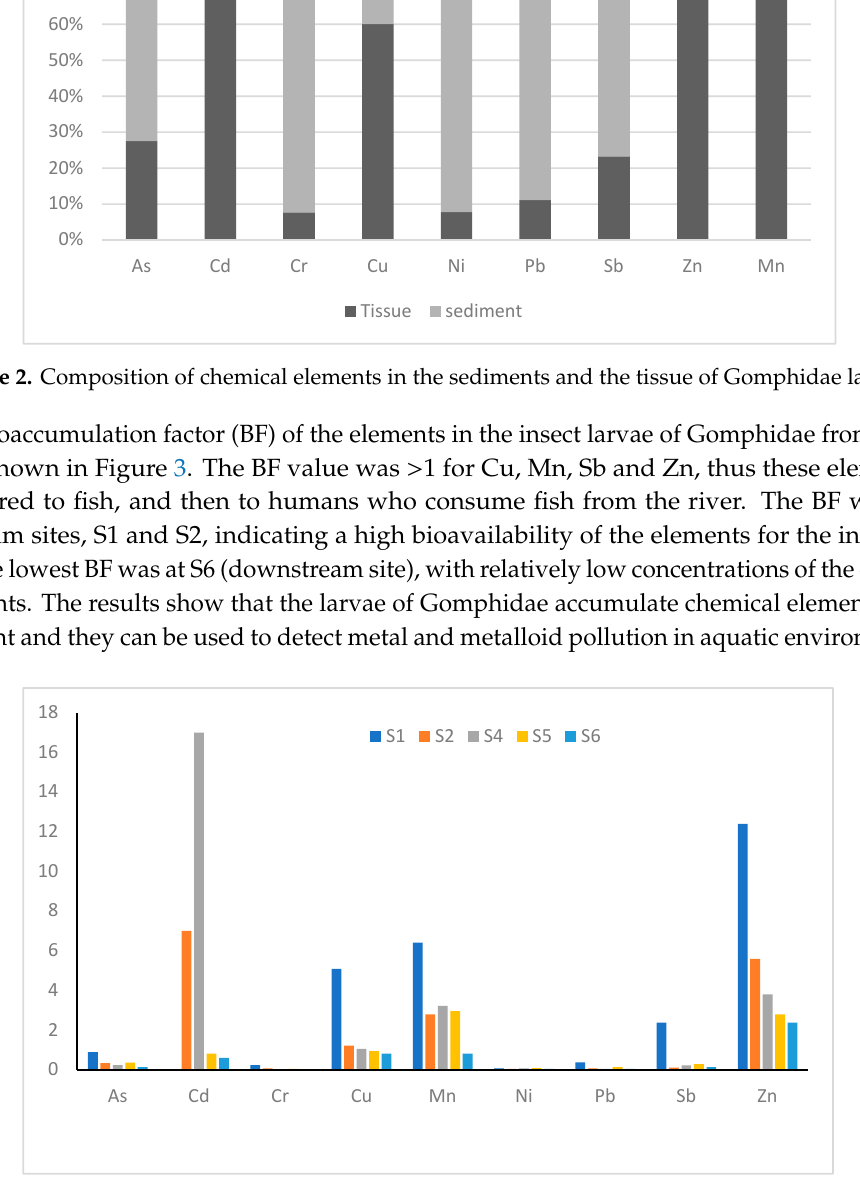
Figure 3. Bioaccumulation factor (BF) for larvae of Gomphidae samples from the Blyde River (ratio of concentrations of chemical elements in the larval tissue and in the sediment).